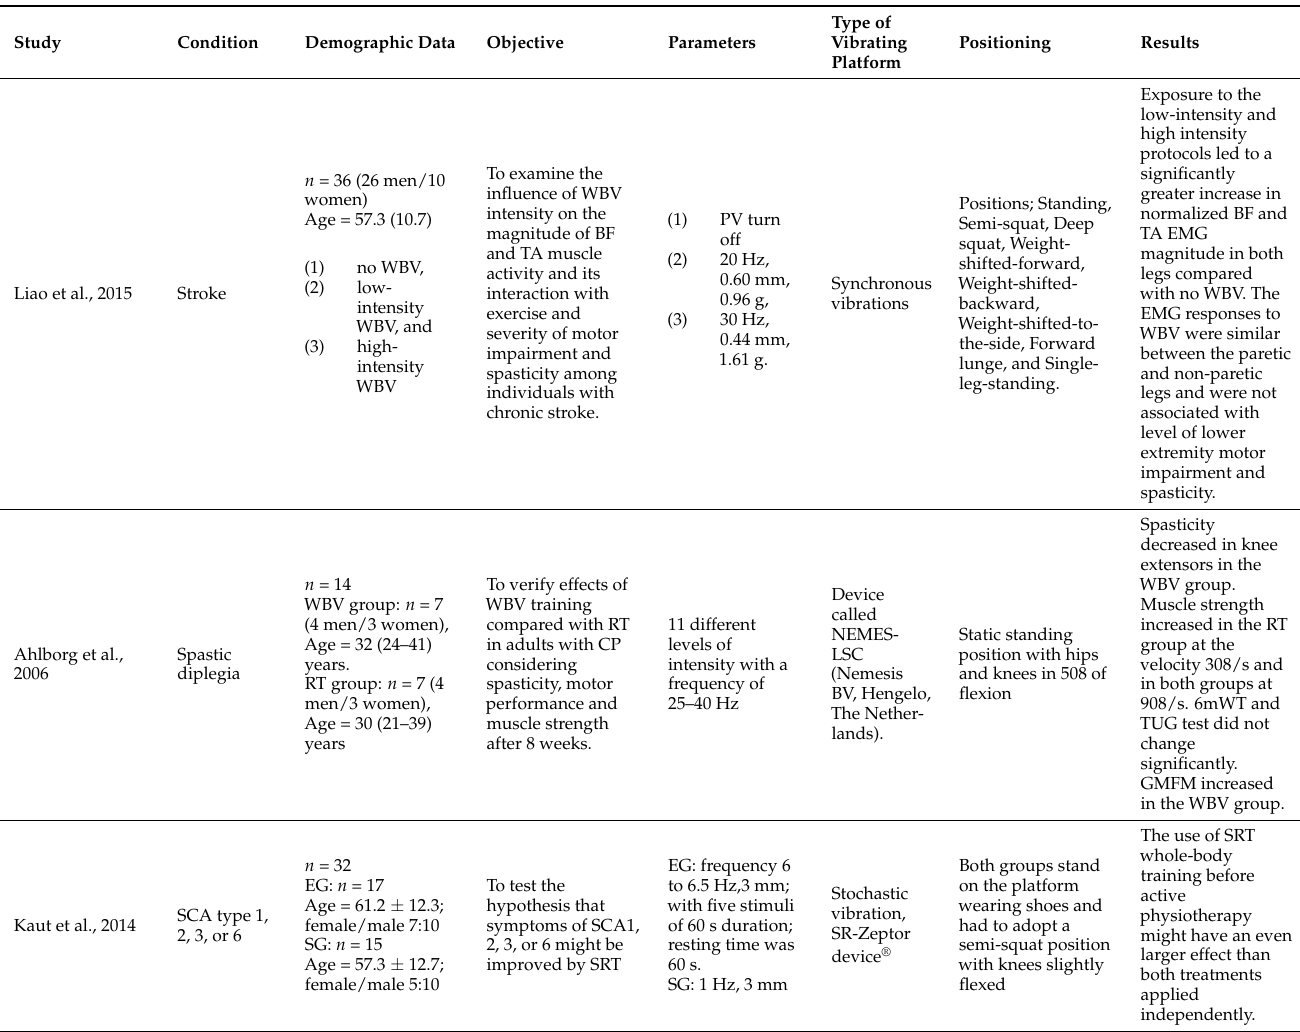
Table 3. Different populations submitted to WBV exercise, with symptoms also observed in the COVID-19 patients: neurological